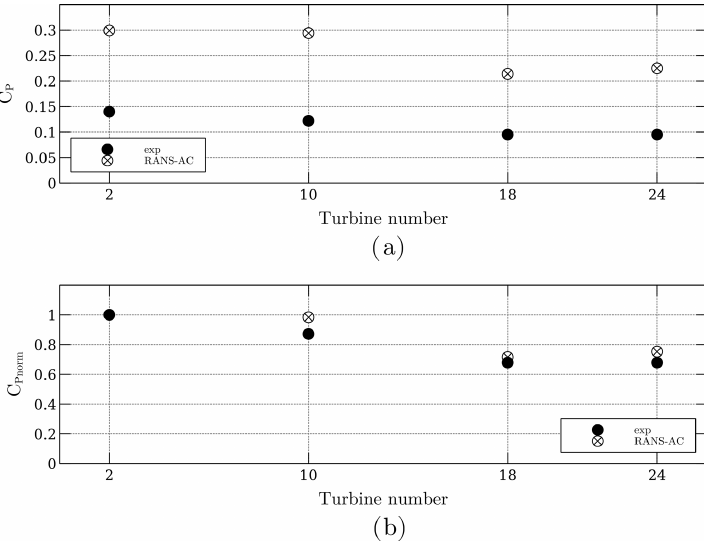
Figure 10. Power coefficients of the four-turbine array. Panel (a) is the actual C P , and panel (b) is the normalized C P .